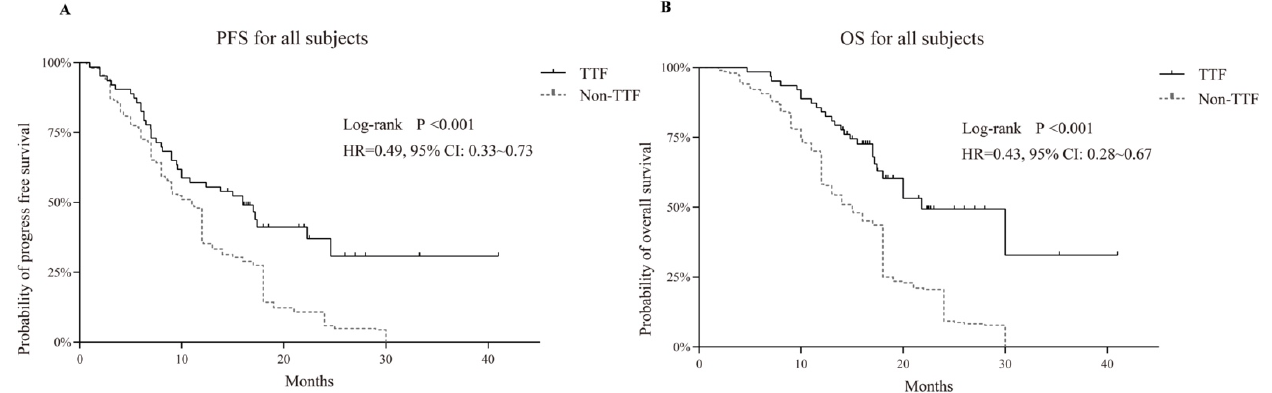
Figure 1. Kaplan–Meier survival analysis in comparing tumor treating fields (TTF) versus non-TTF group; progression-free survival (PFS) is shown in ( A ) and overall survival in ( B ), revealing the prognostic advantages of TTF. Table 2. Univariate and multivariate analyses of progression-free survival (PFS) in GBM patients. Univariate Analysis Multivariate